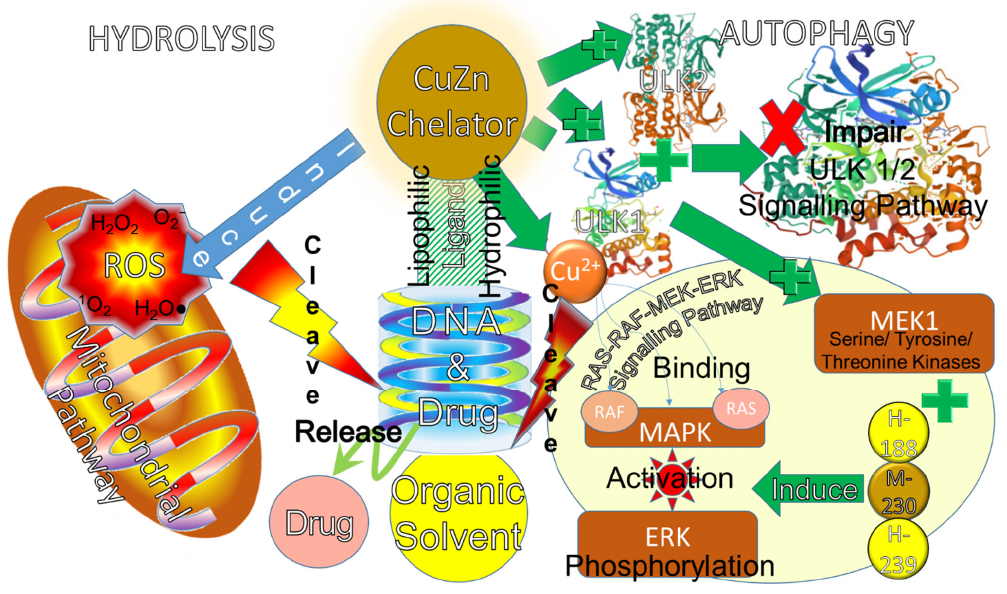
Figure 3. Hydrolysis and autophagy degradation mechanisms of lipophilic or